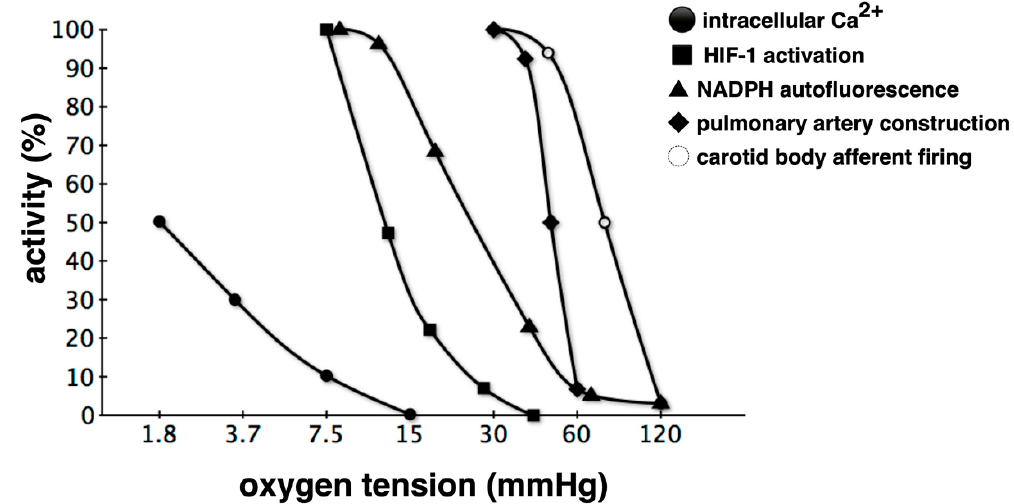
Figure 3. Relationship between oxygen tension and activities of hypoxic responses. Classification based on the partial pressure of O 2 that triggers a response is also possible. Hypoxic pulmonary vasospasm reactions begin at a higher oxygen partial pressure compared to HIF-1 activation, and intracellular Ca 2+ elevation is mostly observed under anoxic conditions. Such varying hypoxic responses are probably due to differences in the corresponding O 2 partial pressure sensing mechanisms [28,31,34,41–44]. Hypoxia detected via several sensors is triggered as a hypoxic response through various effectors, but crosstalk occurs during the transduction of such signals. For example, some voltage-dependent K + channel subtypes are regulated by HIF-1. NAPDH: nicotinamide adenine dinucleotide phosphate .